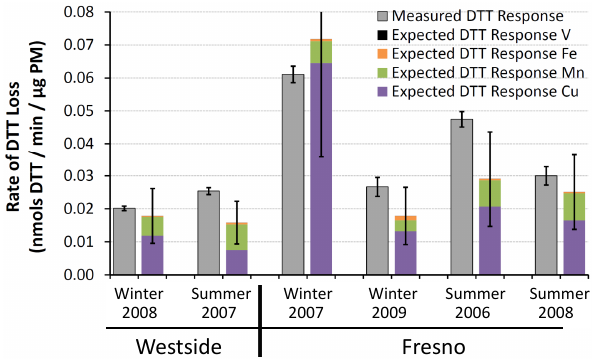
Fig. 6. Measured rates of DTT loss from ambient PM 2 . 5 collected from the San Joaquin Valley of California. For each sample the left gray bar represents the rate of DTT loss measured for the particles (average±1 σ , n = 2 to 4 for each sample), while the right colored bar represents the expected rate of DTT loss from metals based on measured metal concentrations in each sample (Shen et al., 2011) and our DTT response for each metal (Table 1). Error bars for the expected DTT responses represent 1 σ , propagated from uncertain- ties in each metal